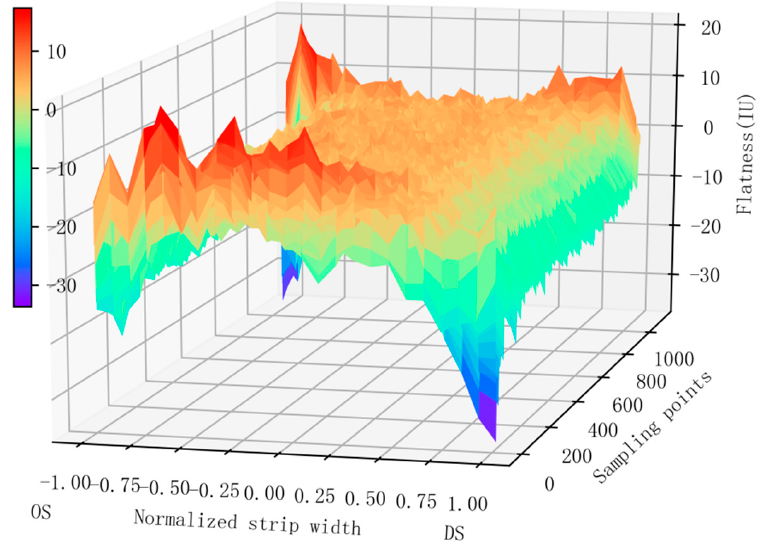
Figure 1. Three − dimensional strip flatness.